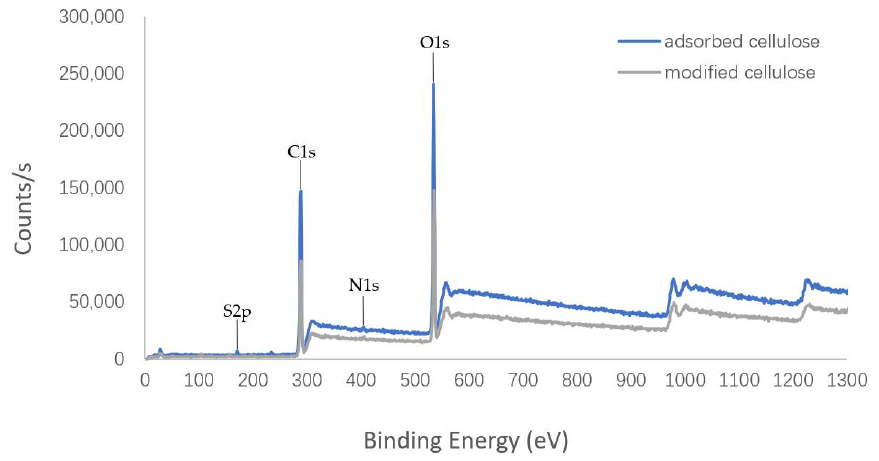
Figure 7. XPS image of cellulose.